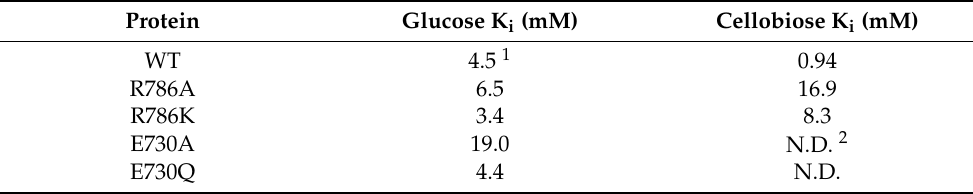
Table 1. Glucose and cellobiose inhibition kinetics.